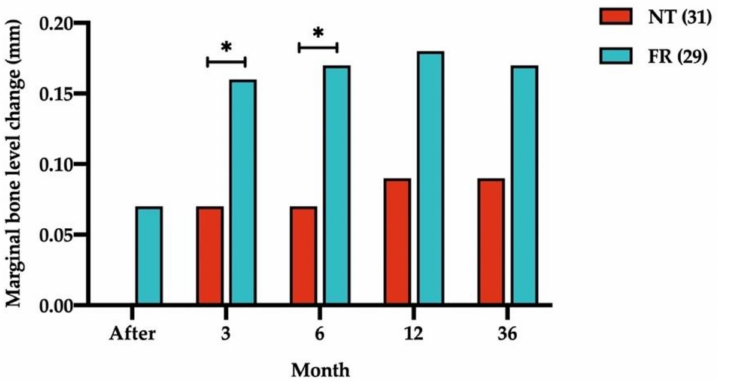
Figure 3. Comparison of mean marginal bone levels with natural teeth (NT) and fixed restorations (FRs) in the opposing arch group at all times. Numbers in parentheses indicate the numbers of NT and FRs. Measurements at the bottom of the graph refer to the time of implant loading. * p < 0.05.